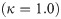
Bistability of the model.A Sketch of the microcircuit model serving as a prototype for the areas of the multi-area model (figure and legend adapted from figure 1 of Potjans and Diesmann [23], with permission). B Sketch of the most common laminar patterns of cortico-cortical connectivity of the multi-area model. C Population-averaged firing rates encoded in color for a spiking network simulation of the multi-area model with low external drive (κ=1.0). D As C but for increased external drive κ=1.125. The color bar refers to both panels. Areas are ordered according to their architectural type along the horizontal axis from V1 (type 8) to TH (type 2) and populations are stacked along the vertical axis. The two missing populations 4E and 4I of area TH are marked in black and firing rates <10-2Hz in gray. E Histogram of population-averaged firing rates shown in C for excitatory (blue) and inhibitory (red) populations. The horizontal axis is split into linear- (left) and log-scaled (right) ranges. F as E corresponding to state shown in D.